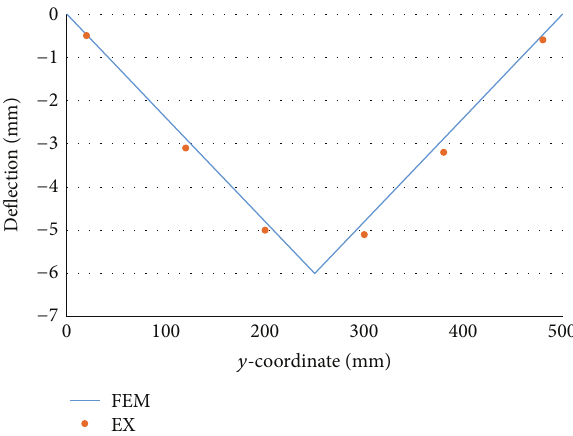
Figure 7: Deflection distribution in the neutral plane.